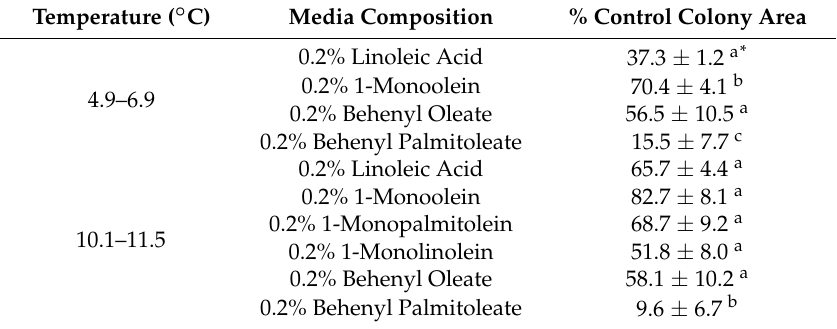
Table 1. Mean ( ± SE) % of control colony area for each media treatment that significantly affected Pd growth in Experiments 1–5.